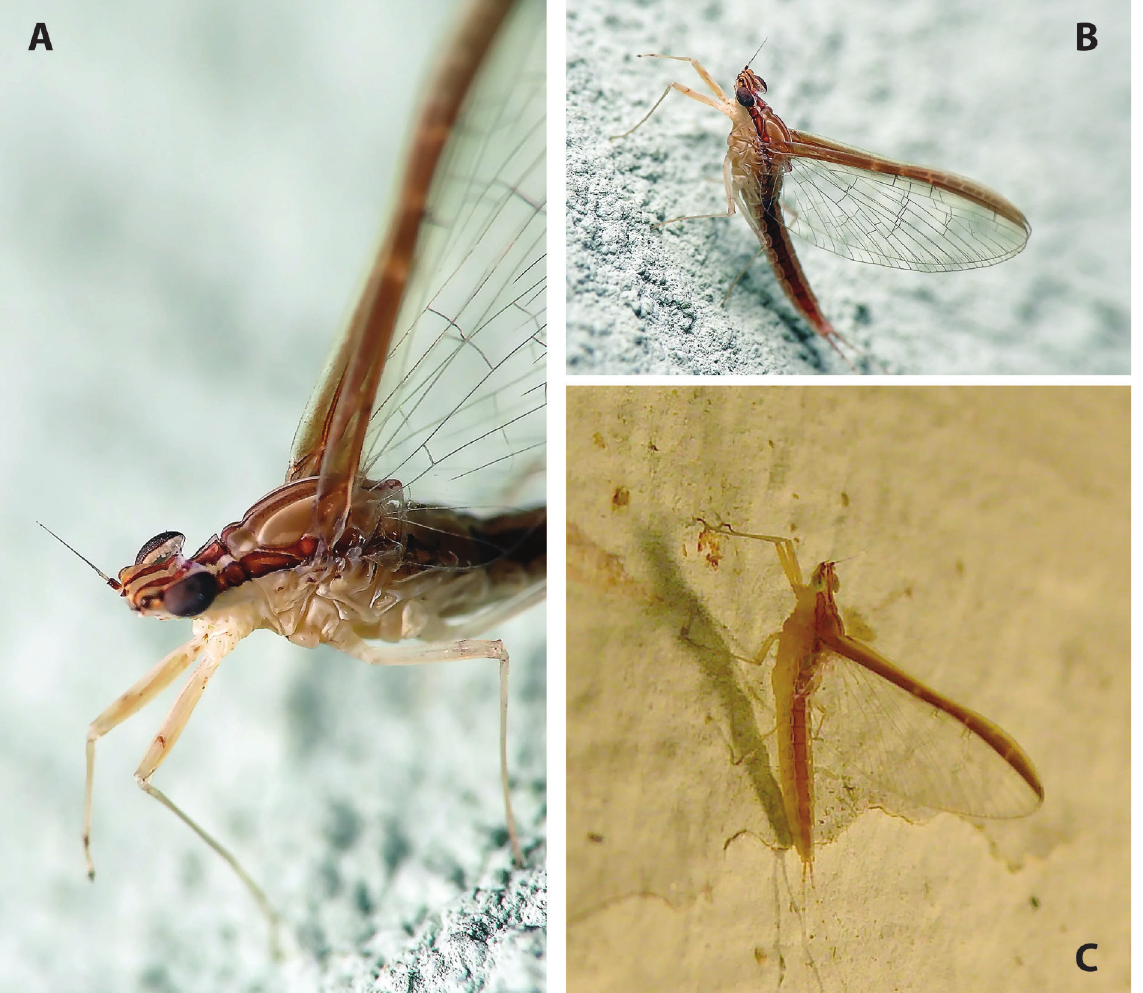
Fig. 1. Cloeon perkinsi adult female in vivo. A–B . Photos taken near Johannesburg, South Africa by Pieter Kotzee. C . Photo taken in Gaborone, Botswana by Christine Sydes. (C published on